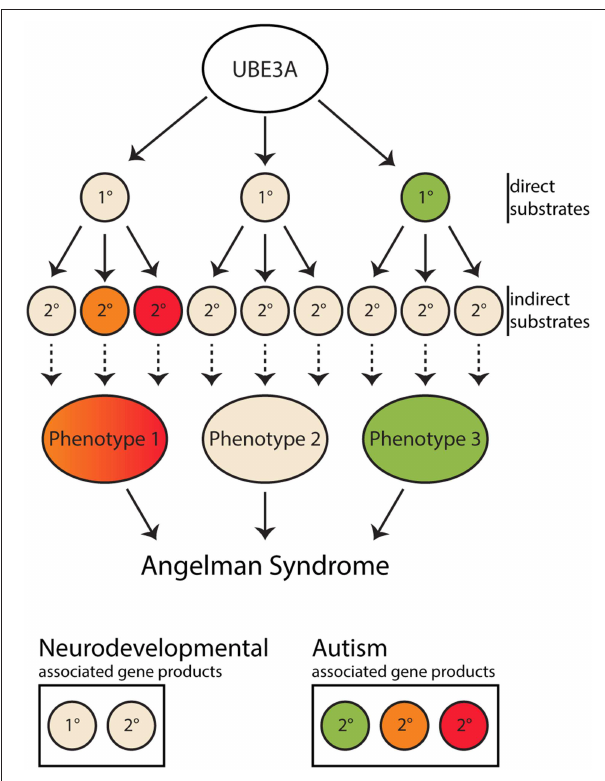
FIGURE 1 | Diagram of UBE3A substrate cascade to Angelman syndrome. Angelman syndrome is caused by the pathological loss of maternal UBE3A protein expression, resulting in the loss of regulation of its pool of downstream substrates. UBE3A direct interactors/substrates are labeled as a 1 ◦ inside a circle. Indirect substrates/changes are labeled as 2 ◦ inside a circle. Gene products associated with neurodevelopment are in tan colored circles and associated with Autism spectrum disorders are colored. Following the loss of UBE3A changes to these 1 ◦ substrates are the initiators of cascade of events which lead to 2 ◦ changes. These 2 ◦ changes can be in the form of protein-protein interactions, cell biological, electrophysiological, etc. The convergence of these 2 ◦ and downstream changes produce phenotypes characteristic of Angelman syndrome. Given some proteins known to be misregulated in ASDs are primary or secondary interactors in this UBE3A-dependent pathway, as indicated by the colored substrates, the phenotypic overlap between Angelman Syndrome and autism spectrum disorders it is not surprising. Through the study of UBE3A substrates, more overlapping molecular changes underlying shared phenotypes may become apparent.